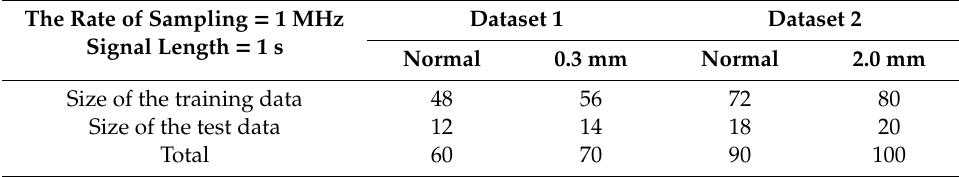
Table 4. Details of the datasets employed to assess the o ff ered method.